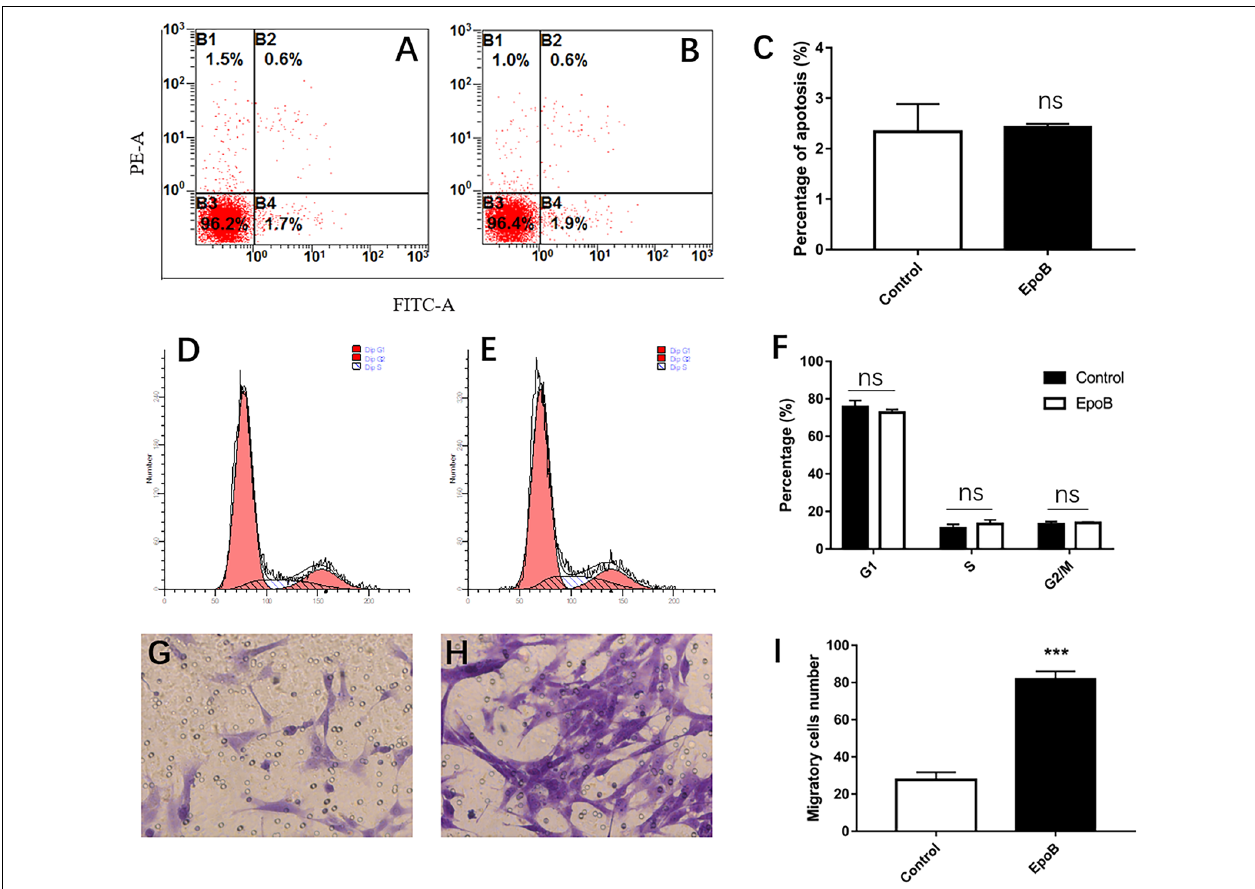
FIGURE 5 | Effects of EpoB on SCs. EpoB has no effect on SC apoptosis (A–C) or the SC cell cycle (D–F) assessed by flow cytometry. (G–I) EpoB significantly promotes migration of SCs by in the transwell assay. *** P < 0.001 compared to the control group. Abbreviations: EpoB, epothilone B; SC, Schwann cell; ns, no